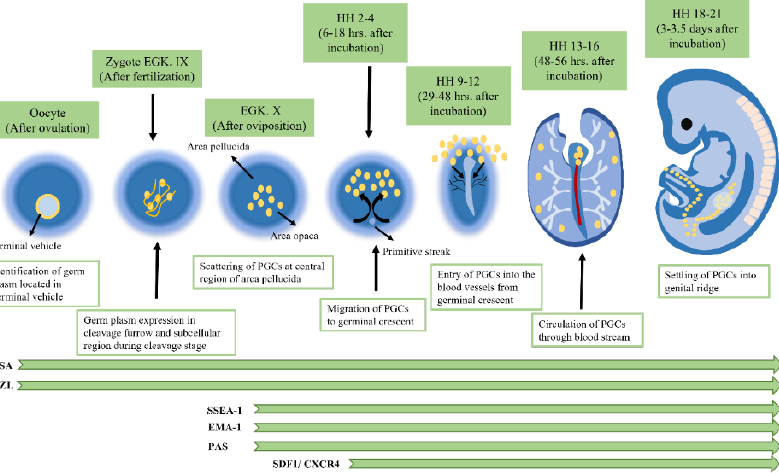
Figure 3. Development of primordial germ cells (PGCs) and expression of markers, shown schematically (modified from Kim and Han [42]).